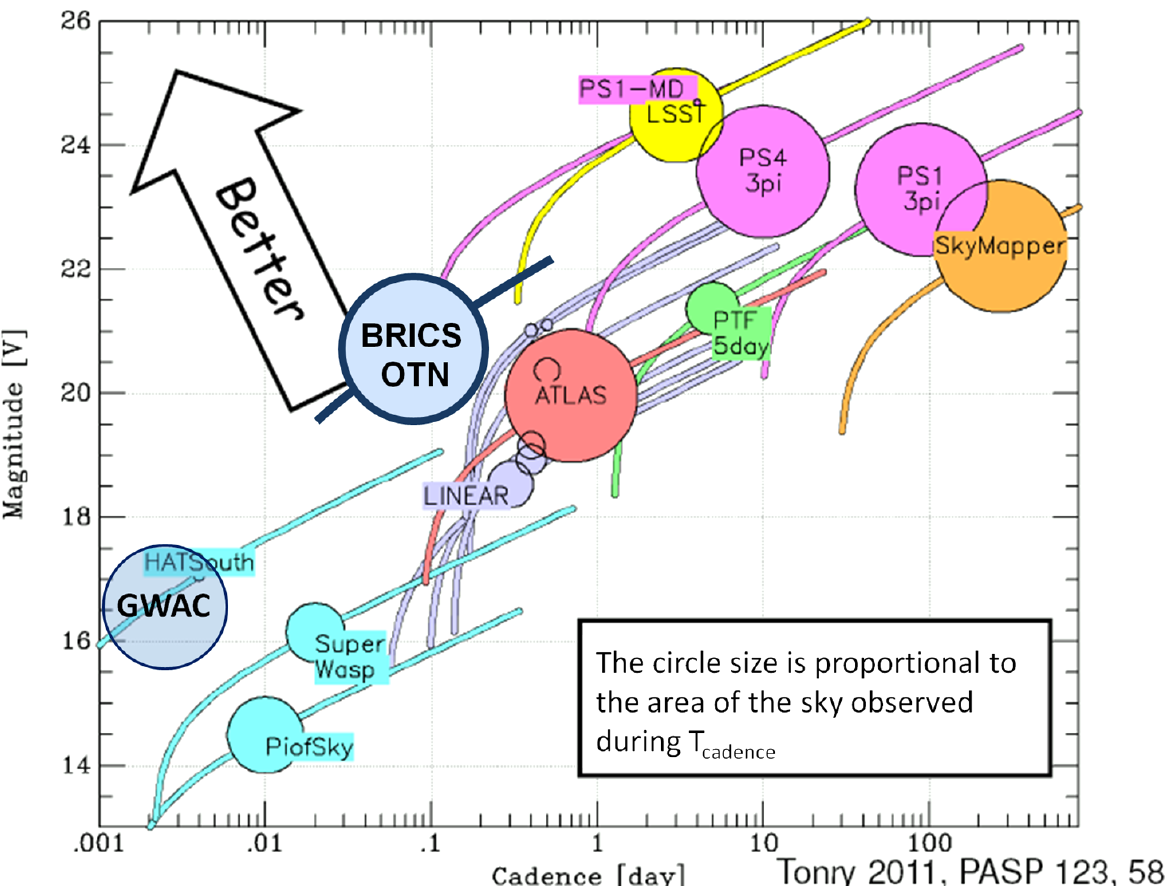
Figure 5. BRICS Optical Transient Network (BRICS OTN) survey merit diagram. Adapted from Tonry